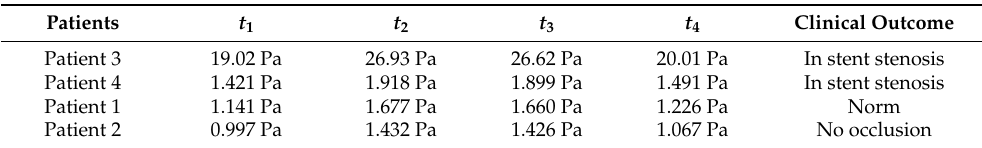
Table 4. Maximum values of ∆ WSS (7) for the selected time points and the clinical effect obtained with this stent placement.